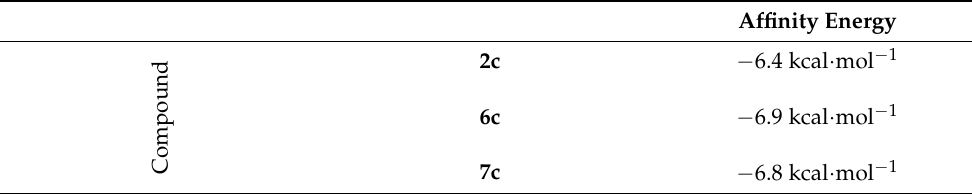
Table 2. Affinity energy values for compounds 2c , 6c and 7c from Vina docking